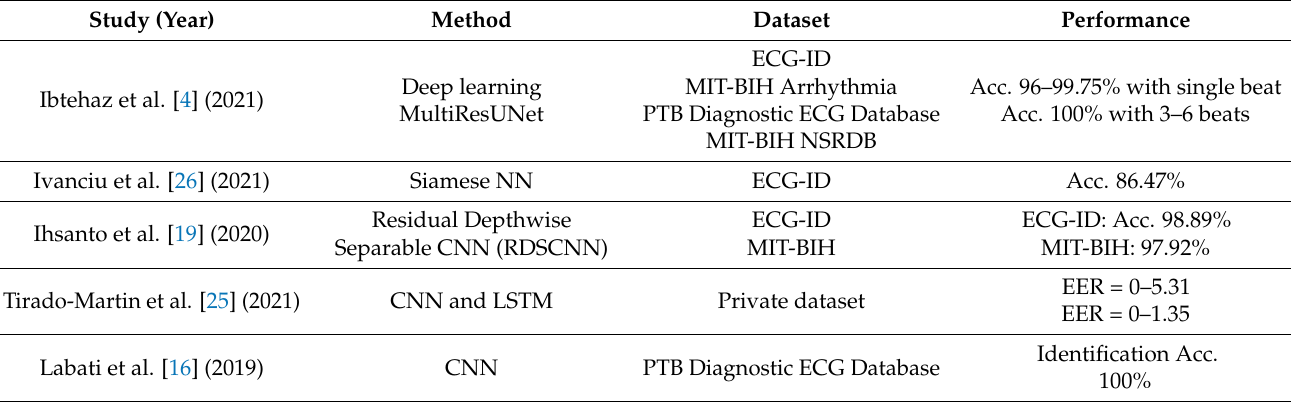
Table 1. Summary of the recent ECG biometrics works that are based on deep learning techniques. Acc. for accuracy, EER for equal error rate.